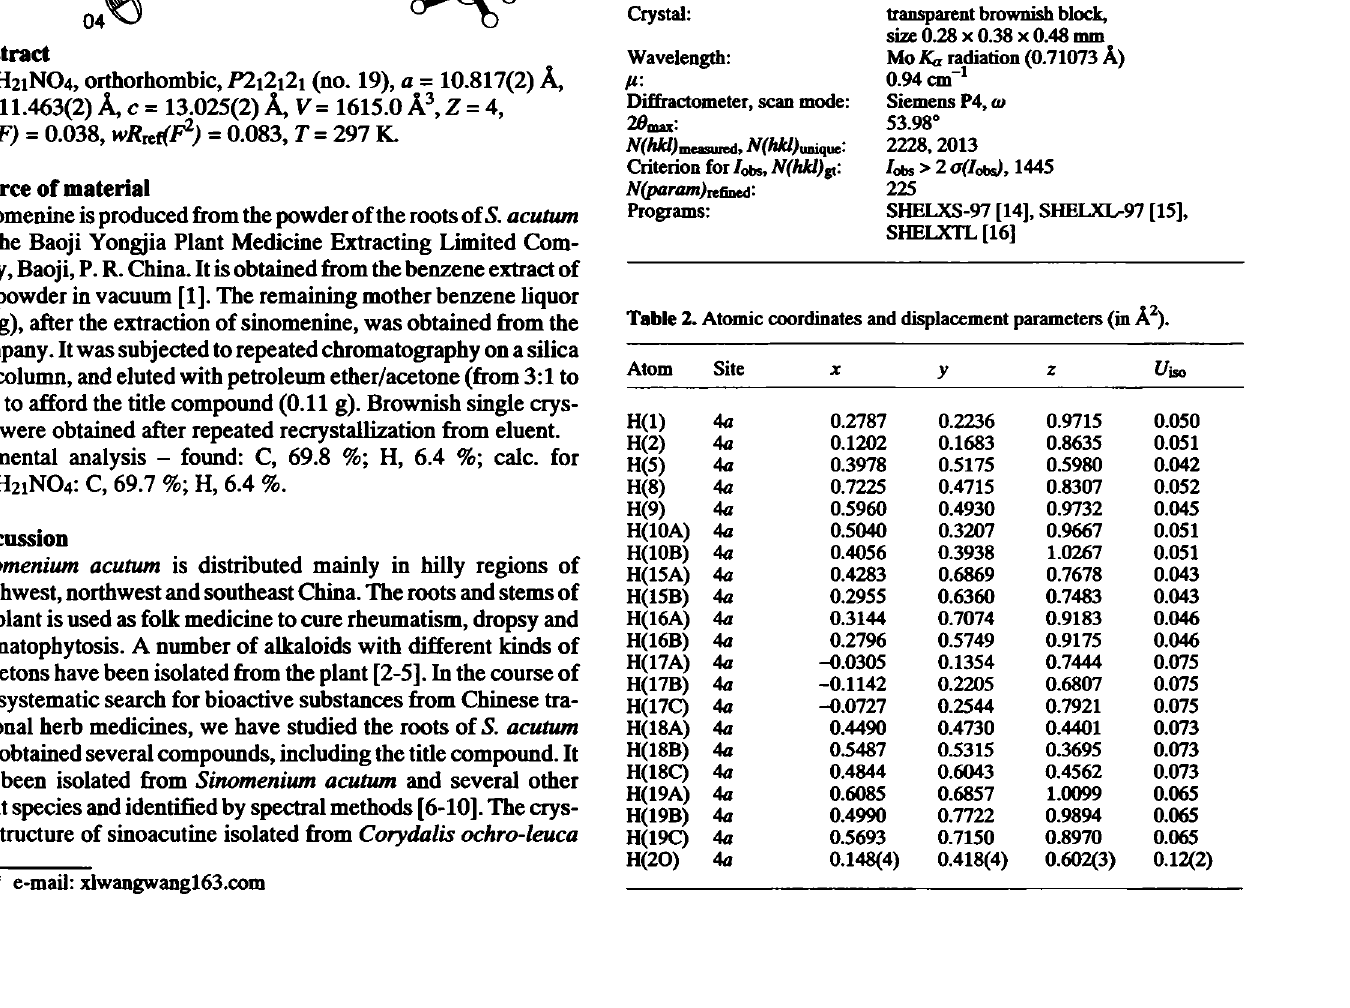
Table 1. Data collection and handling.